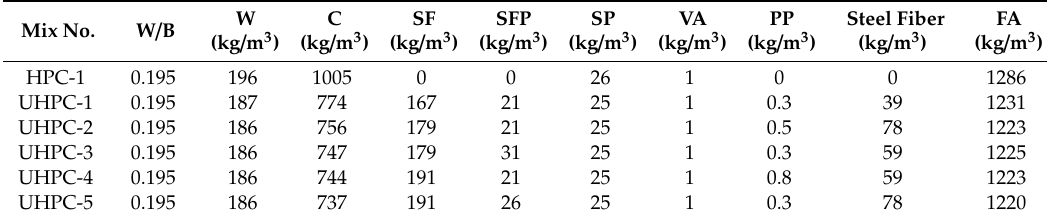
Table 4. Mix proportions of concrete.